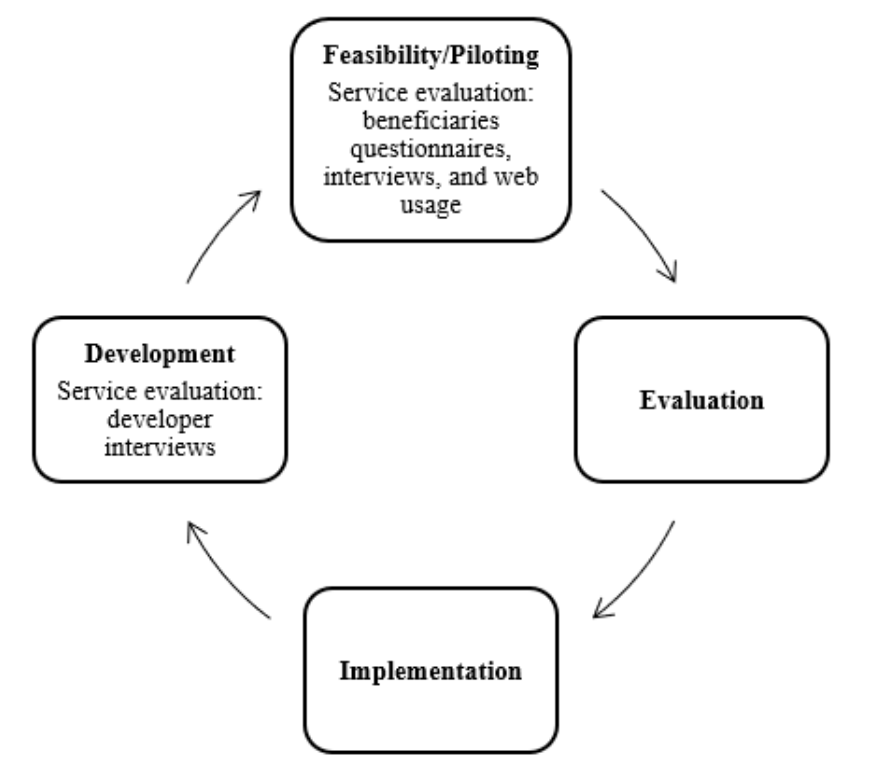
Figure 1. The HeadFIT service evaluation integrated into the MRC Complex Intervention Frame- work.